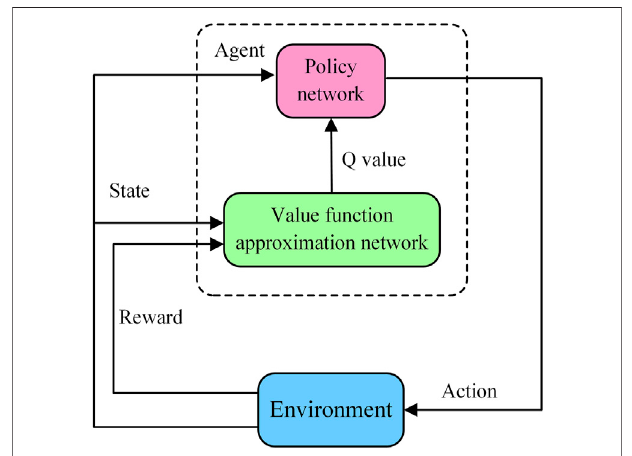
FIGURE 3 | Actor-critic framework schematic diagram.